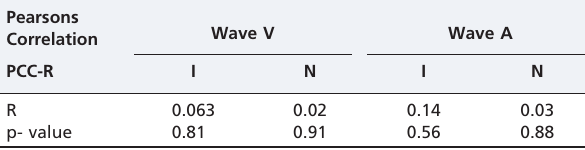
Table 4 - Correlations between the speech-evoked ABR latencies (waves V and A) and the PCC-R index – imitation and nomination tasks for the research